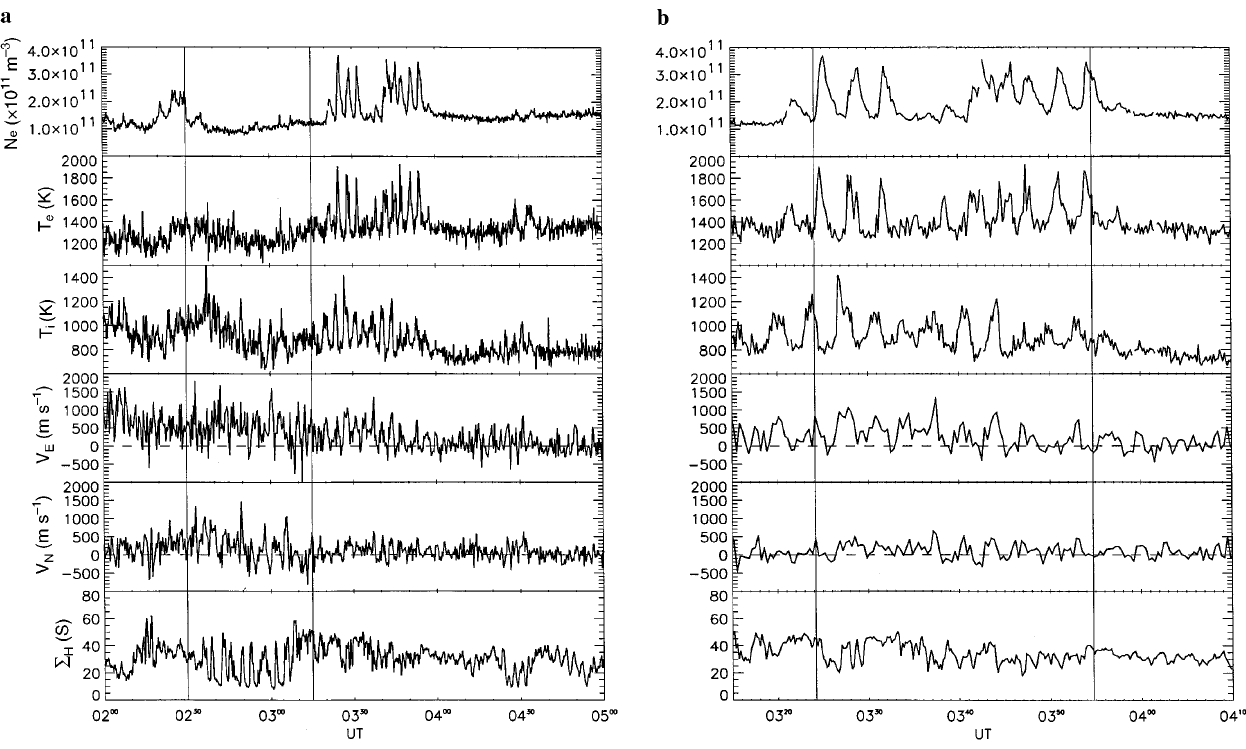
Fig. 2a, b. The EISCAT parameters, electron density at 212.5 km, electron temperature at 212.5 km, ion temperature at 212.5 km, the east-west component of the ion velocity at 278 km, the north-south component of the ion velocity at 278 km and the height integrated